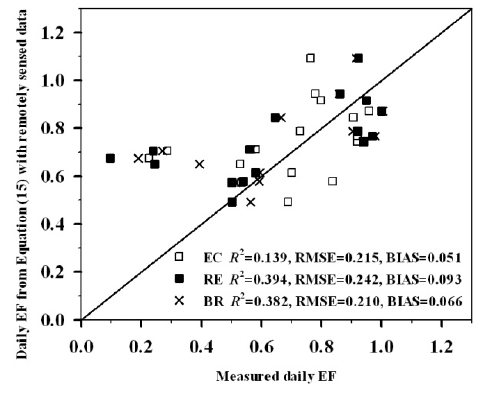
and ( b ) R from MODIS/Aqua products with the s n